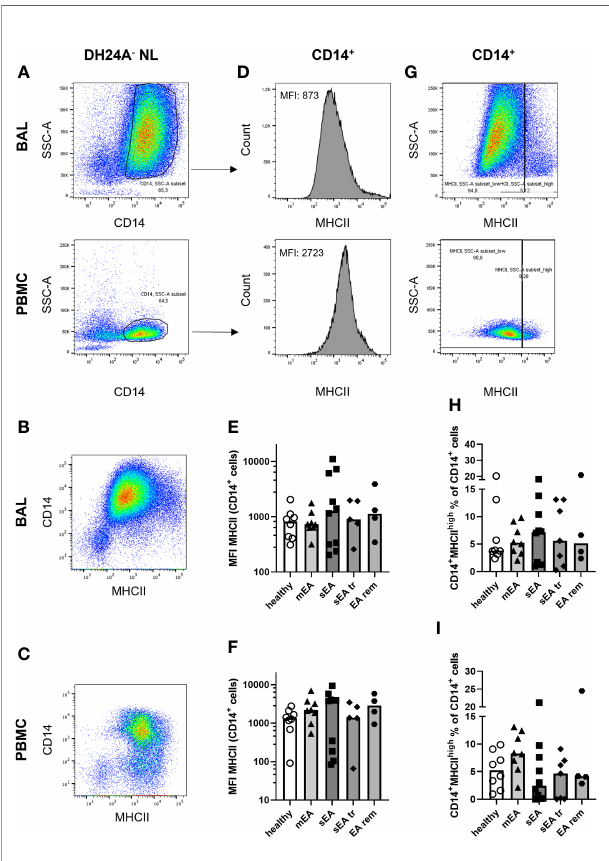
FIGURE 4 | MHCII expression on CD14 + macrophages is similar in BAL samples from horses of all groups. Representative fl ow cytometry plots of one healthy horse ’ s BAL cells (upper row) and PBMC (lower row) are shown for (A) singlet live DH24A - non-lymphocytes (NL) gated for CD14 + cells. MHCII vs. CD14 in DH24A - NL is shown for comparison in (B) BAL cells, (C) PBMC. MHCII expression on CD14 + cells (A) was quanti fi ed as (D) median fl uorescence intensity (MFI), and (G) percentage of MHCII high cells. MHCII expression (MFI) on CD14 + DH24A - NL was similar on (E) BAL cells, or (F) PBMC and frequencies of MHCII high CD14 + cells in (H) BAL cells, or (I) PBMC were similar between horses from all groups. mEA (mild to moderate equine asthma), sEA (severe equine asthma), tr (pre-treated), EA rem (equine asthma in